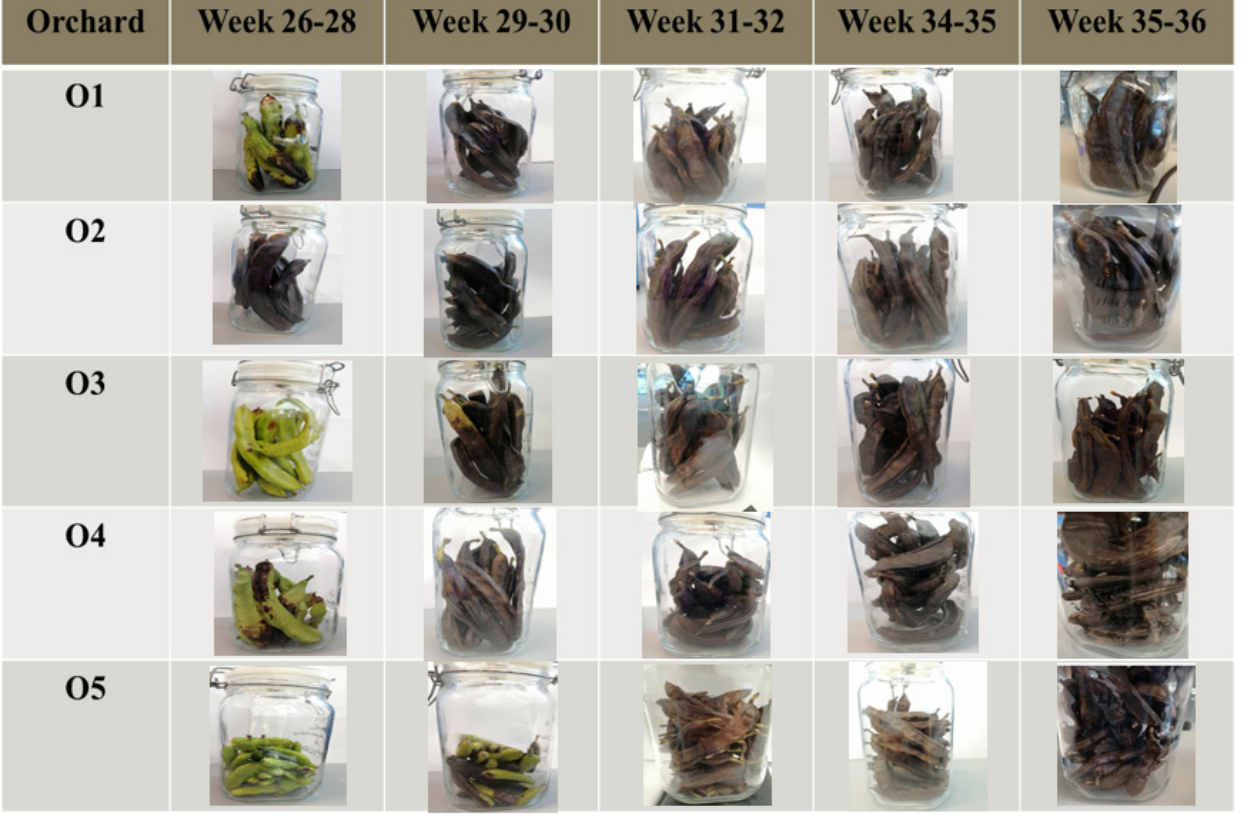
Figure 1. Stages of carob maturation of 5 orchards, from the unripe (green color) to the ripe (dark brown color) stage.